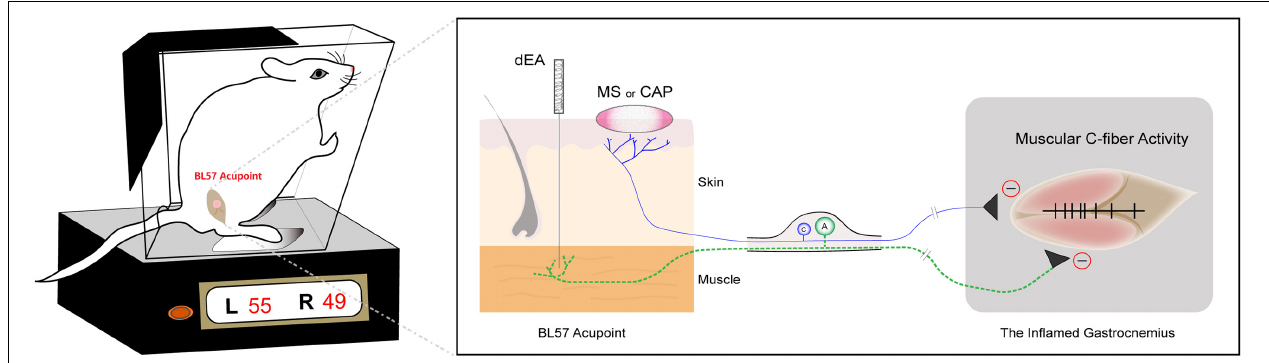
FIGURE 6 | Diagram of distinct primary afferent pathways of deep electroacupuncture (dEA)- and moxibustion-like stimulation (MS)-induced analgesic effects. dEA activates muscular A-fibers at the BL57 acupoint, while noxious MS or capsaicin (CAP) excites cutaneous C-fibers to improve muscle pain behavior via inhibiting spontaneous activity of muscular